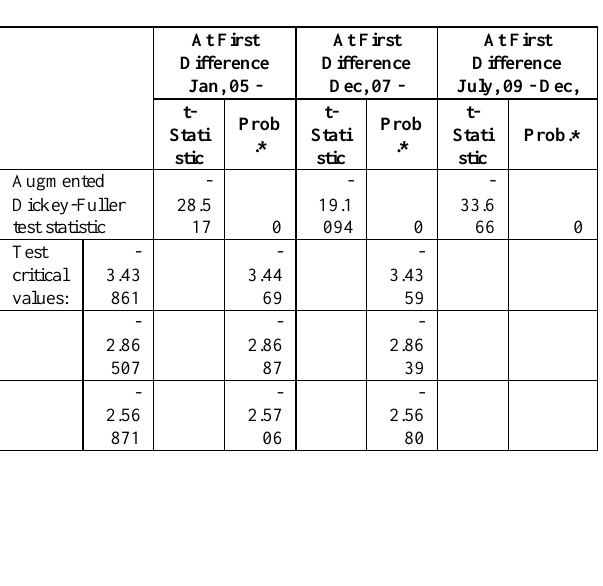
Table 2: The Results of ADF Test on Gold Prices (At First Difference)